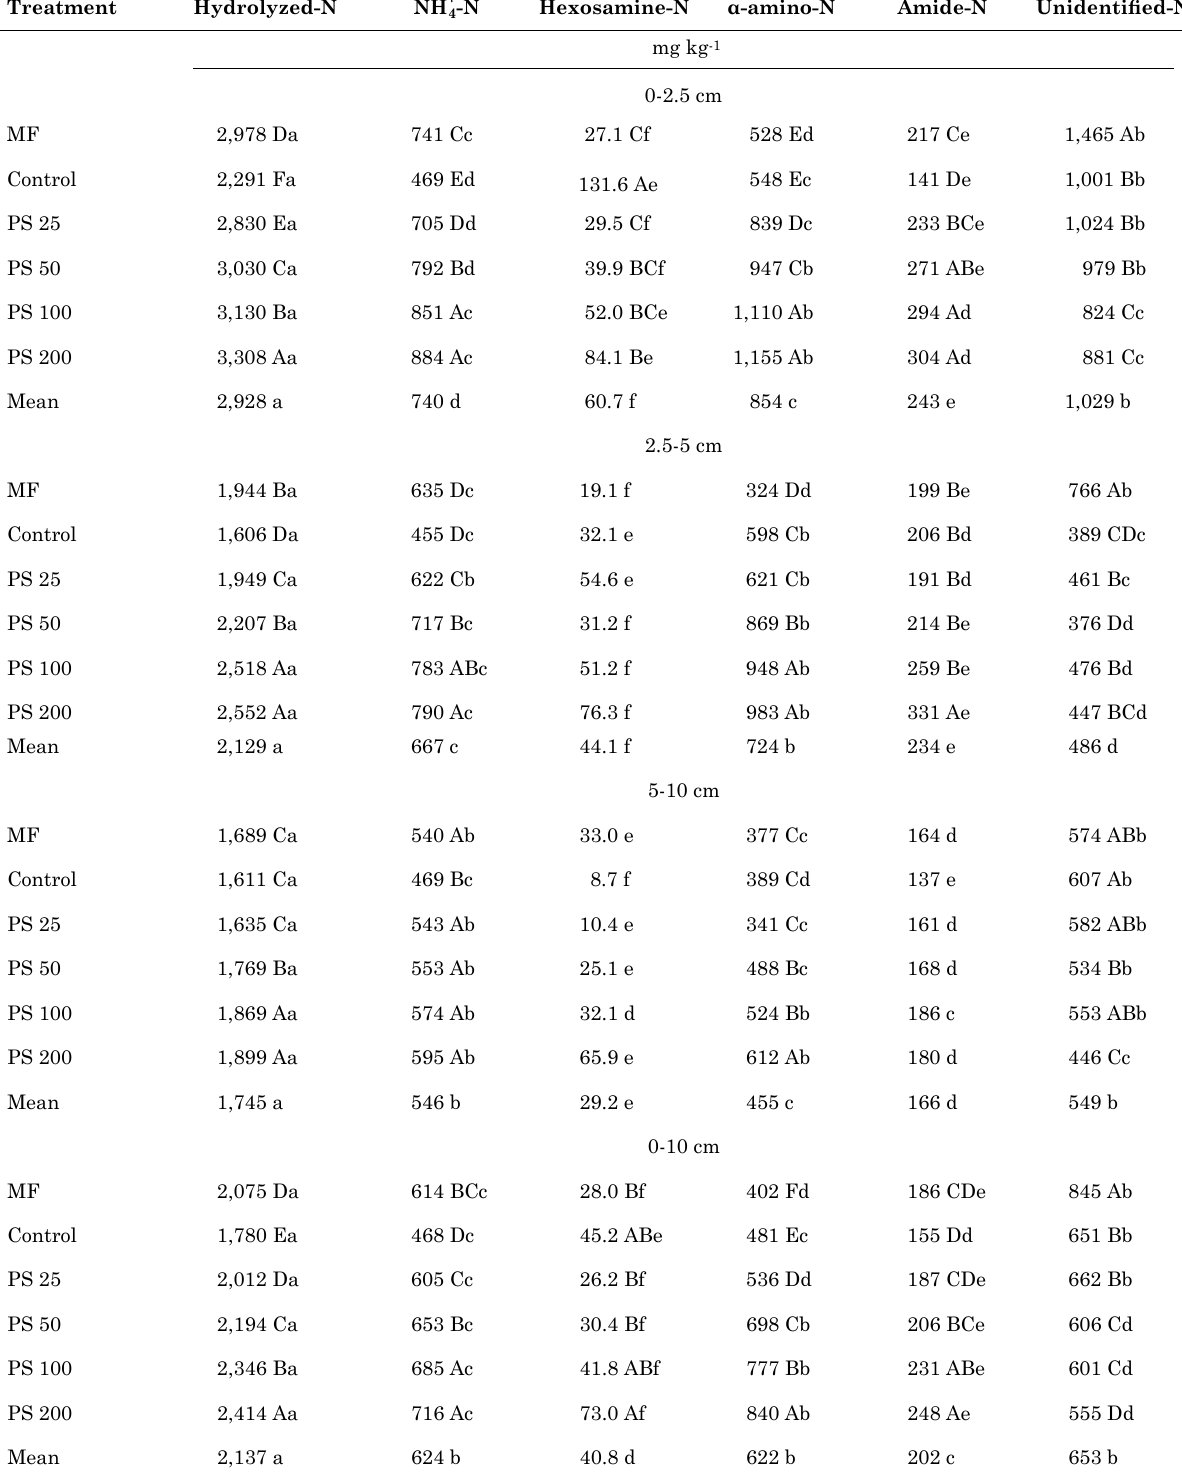
Table 5. Contents of organic nitrogen hydrolyzed in acid medium (hydrolyzed-n) and in its diverse fractions in soil layers up to a depth of 10 cm in a latossolo Vermelho distroférrico (Typic Hapludox) subjected to 10 years of annual fertilization with mineral fertilizer (mF) and pig slurry (PS) at the rates of 0 (control), 25, 50, 100, and 200 m -3 ha -1 in a no-till system. mean values of four